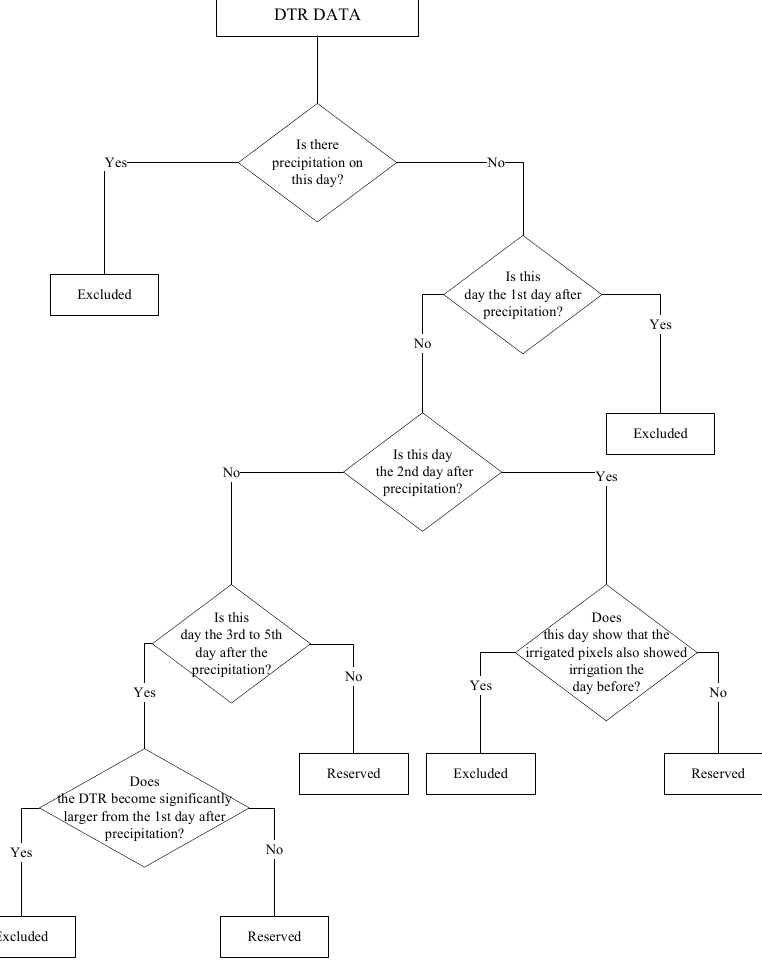
Figure 4. Decision tree classification excluding data affected by precipitation.